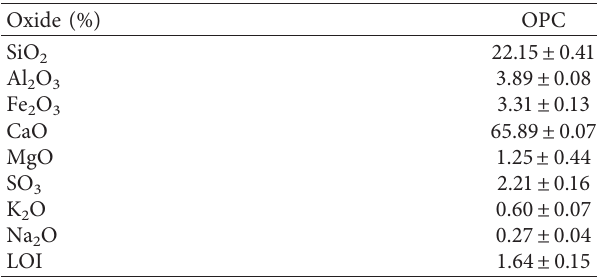
Table 1: Chemical composition of test